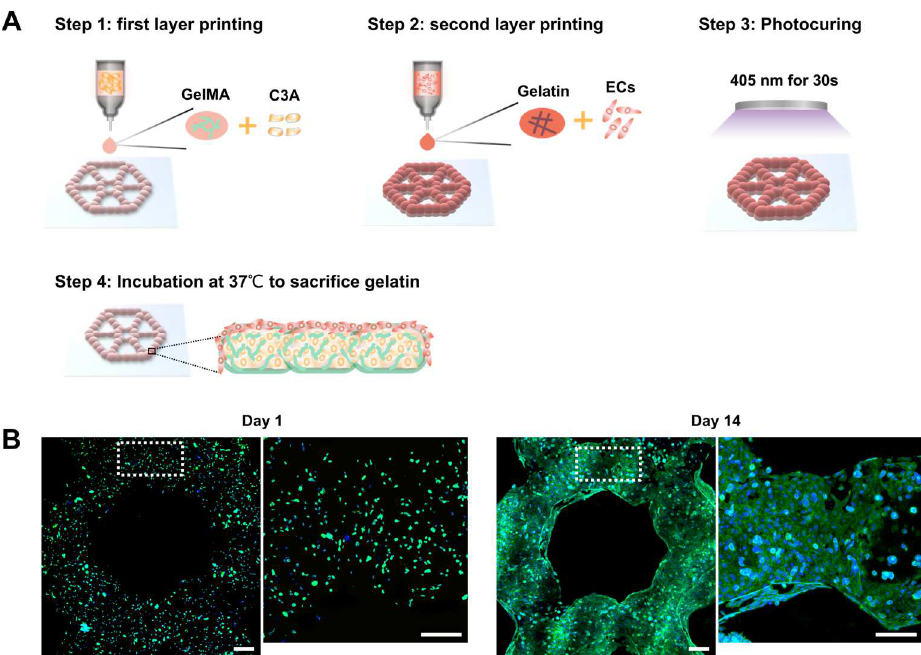
Figure 4. Endothelialized liver lobule-like constructs fabrication and culture. ( A ) Schematic illus- trations of printing endothelialized liver lobule-like constructs in four steps. ( B ) F-actin staining of cells to show cell morphology at day 1 and day 14. Scale bar: 200